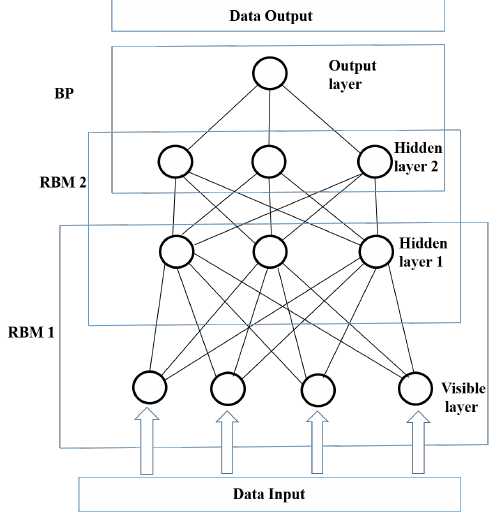
Figure 3. Architecture of a deep belief network (DBN) with two RBMs